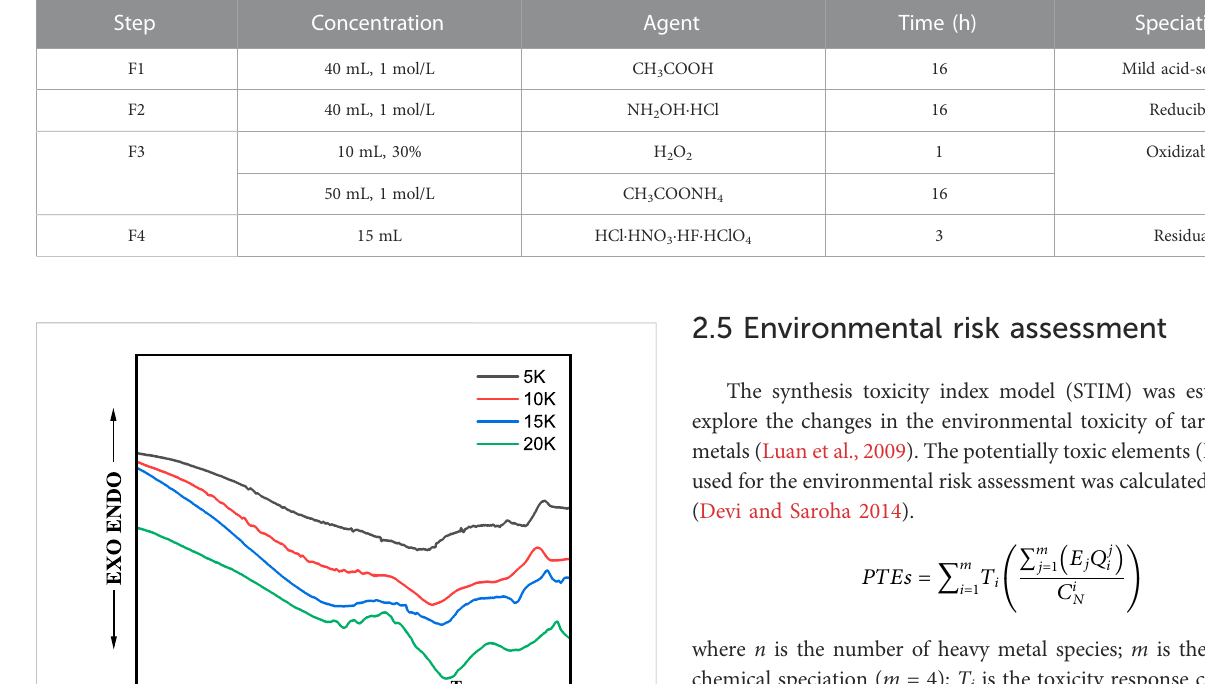
TABLE 2 Detailed parameters of the Modi fi ed Sequential Extraction Method for based on GB/T